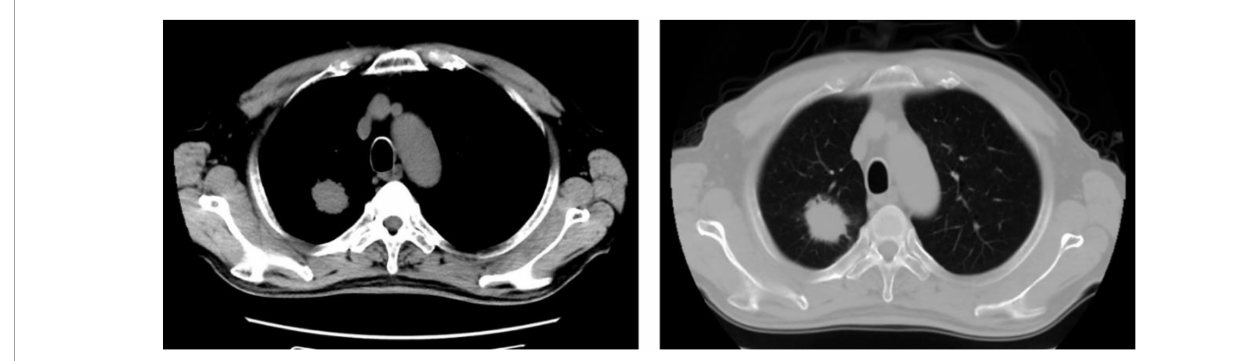
FIGURE2 Chest computer tomography (CT) showed a space-occupying lesion in the right lung.